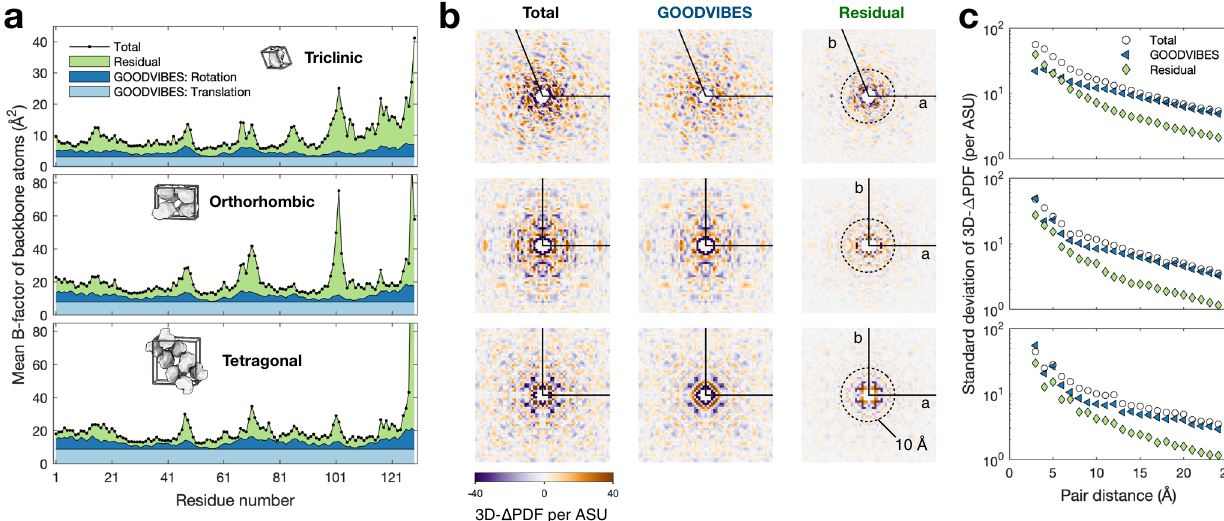
Fig.5|ContributionofinternalproteinmotiontoADPsanddiffusescattering. a ADPs of backbone atoms for each lysozyme polymorph (top to bottom: triclinic, orthorhombic, and tetragonal). For clear visualization, the full set of ADPs was reduced to a mean equivalent isotropic B-factor for each residue. Using GOOD- VIBES, the total B-factor (black line and symbols) is decomposed into rigid-body motion due to lattice disorder (light and dark blue shading) and the residual attributedtointernalproteinmotion(greenshading).AsdescribedinMethods,the B-factorsfromrigid-bodymotionwerefurtherdecomposedintotranslations(light blue shading) and rotations (dark blue shading), which vary among residues depending on their distance from the rotation center. The contribution of lattice disorder to B-factors is signi fi cant in all three polymorphs, and the residual B-factorshaveasimilaroverallmagnitude(notethatthey-axisscaleisdifferentfor